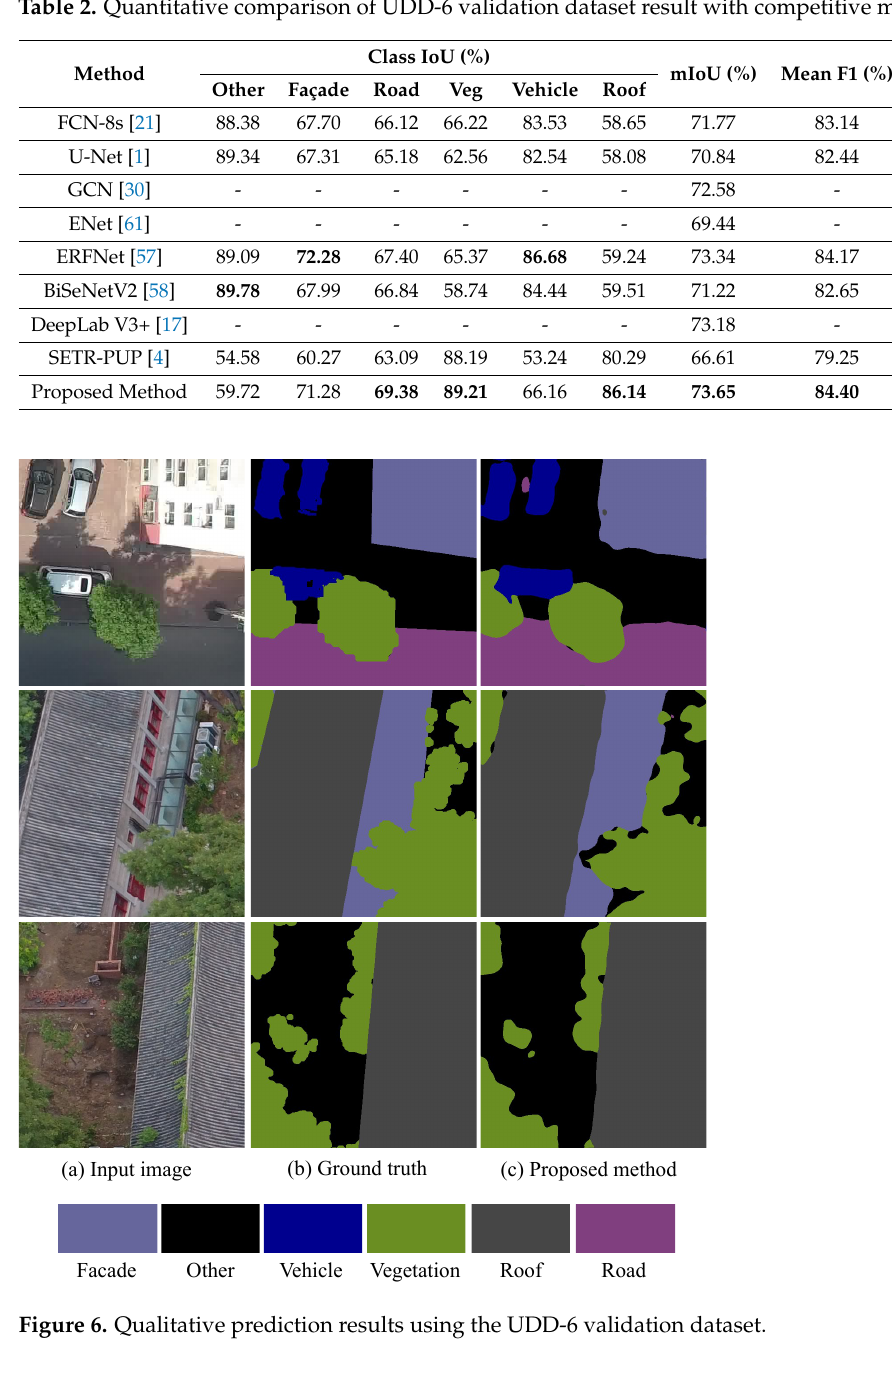
Table 2. Quantitative comparison of UDD-6 validation dataset result with competitive methods.